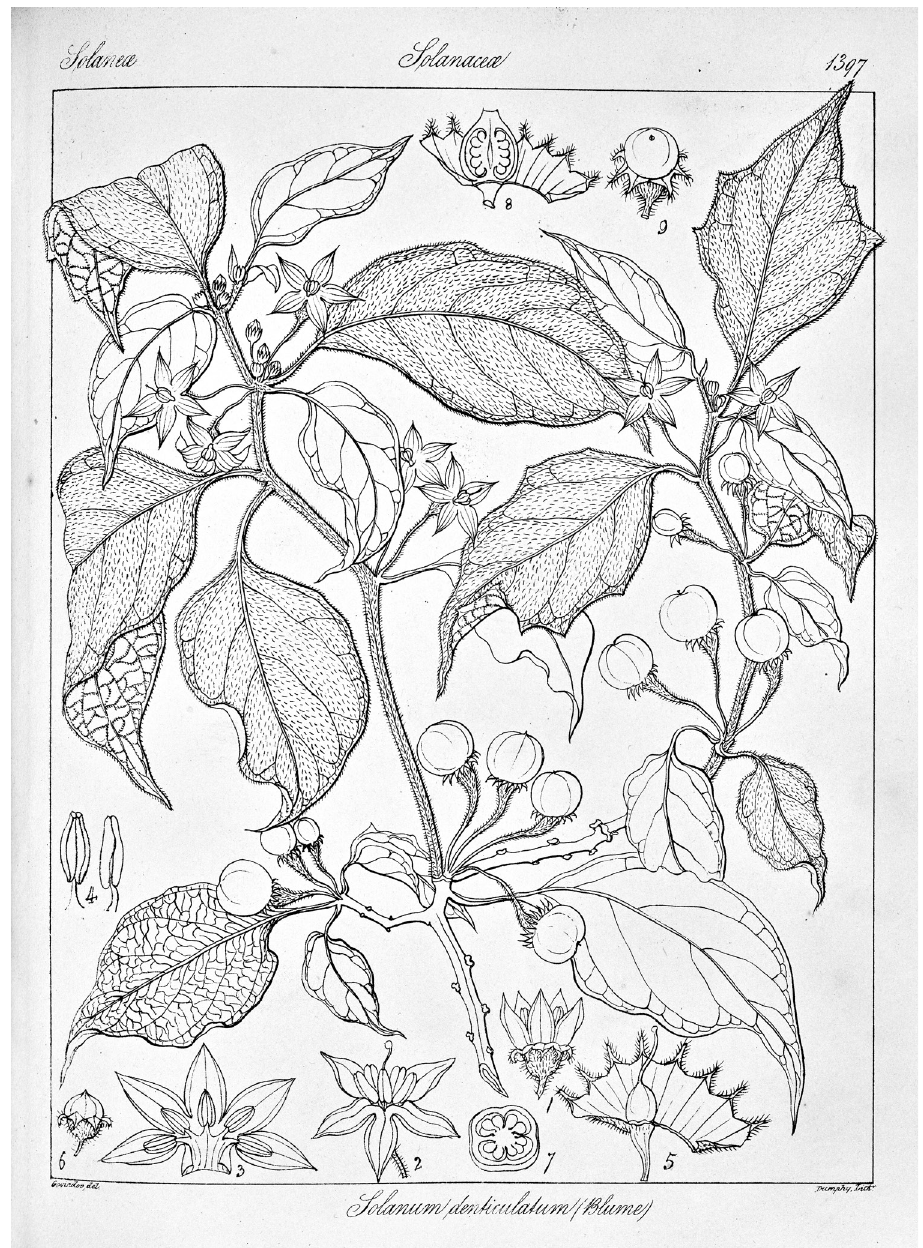
Figure 10. Lycianthes biflora (Lour.) Bitter. Reproduced from Wight (1850: tab. 1397, as S. denticulatum Blume). Courtesy of the NHM Library and Archives reproduced with